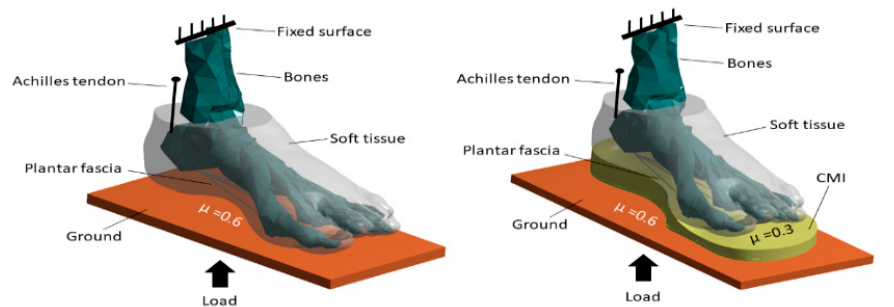
Figure 2. Finite element analysis models showing the foot without and with a custom-made insole (CMI). The boundary and loading conditions prescribed in the simulation were illustrated.